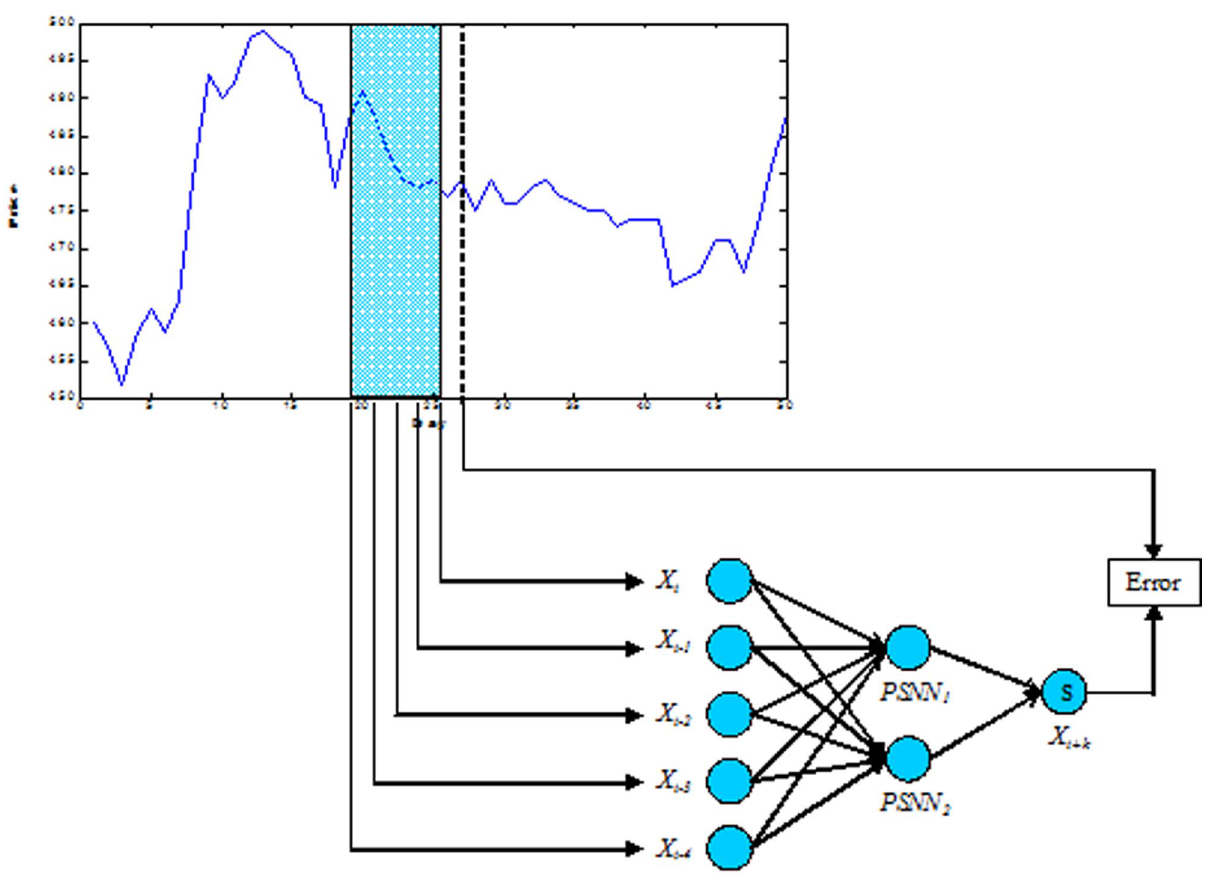
Figure 9. Neural network learns the non-stationary signal.